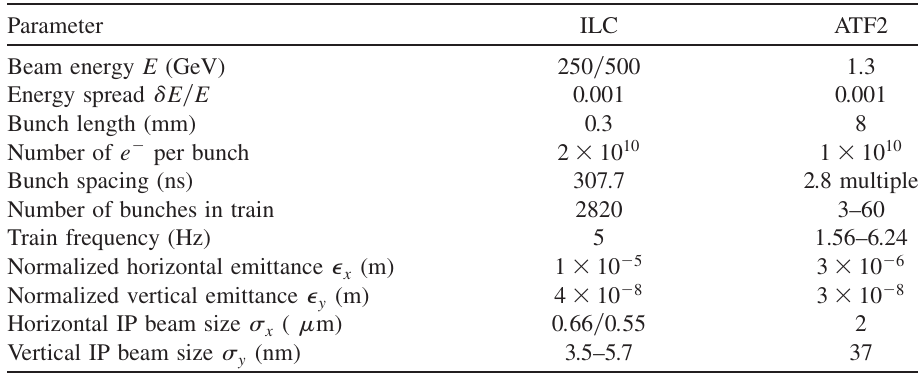
TABLE I. Comparison of ILC and ATF2 beam parameters [2,4].